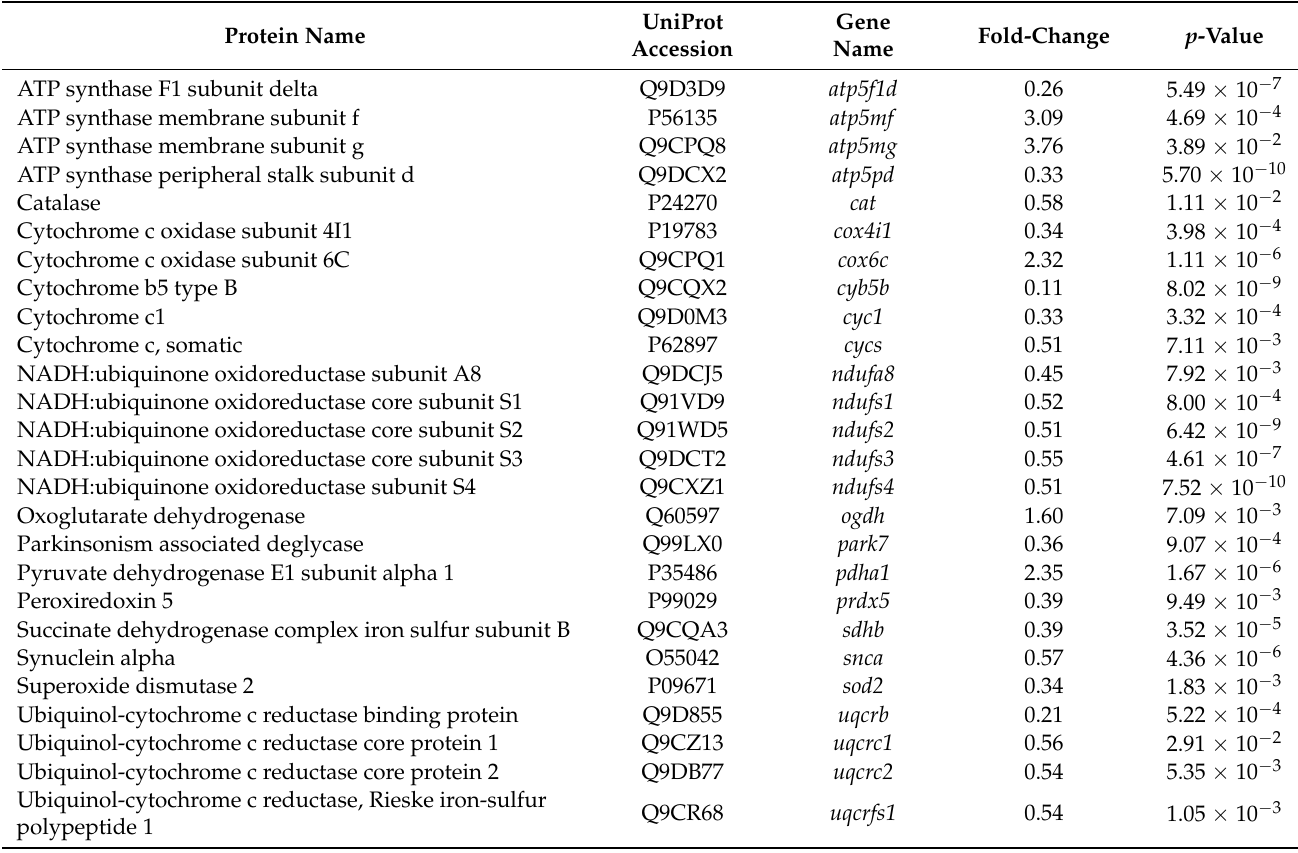
Table 2. Differentially expressed proteins related to mitochondrial dysfunction from the SWATH